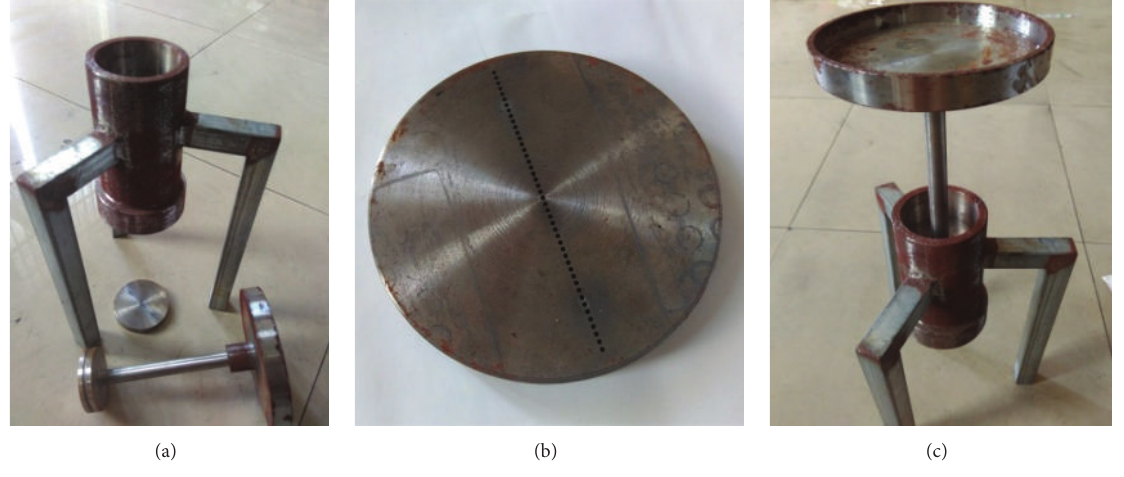
Figure 1: Apparatus used for alignment of CNTs in natural rubber.